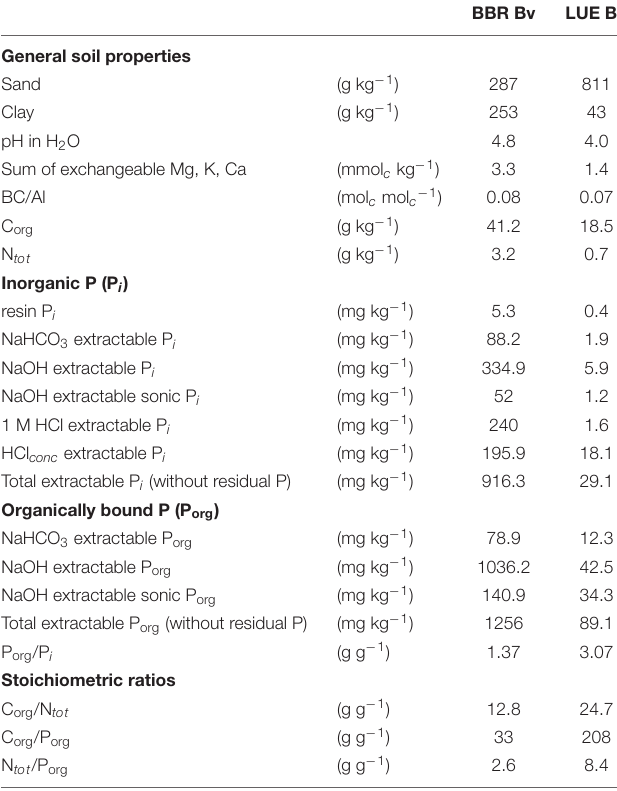
TABLE 1 | Properties of the soil materials from the forest sites Bad Brückenau (BBR, Bv horizon) and Unterlüss (LUE, Bh horizon); BC/Al refers to the ratio between the sum of exchangeable base cations (Mg, K, Ca) and exchangeable Al; inorganic P (P i ) and organic P (P org ) used in element ratios refer to the respective total extractable fractions; data are from Meller et al., 2019 except for the concentration of P fractions.